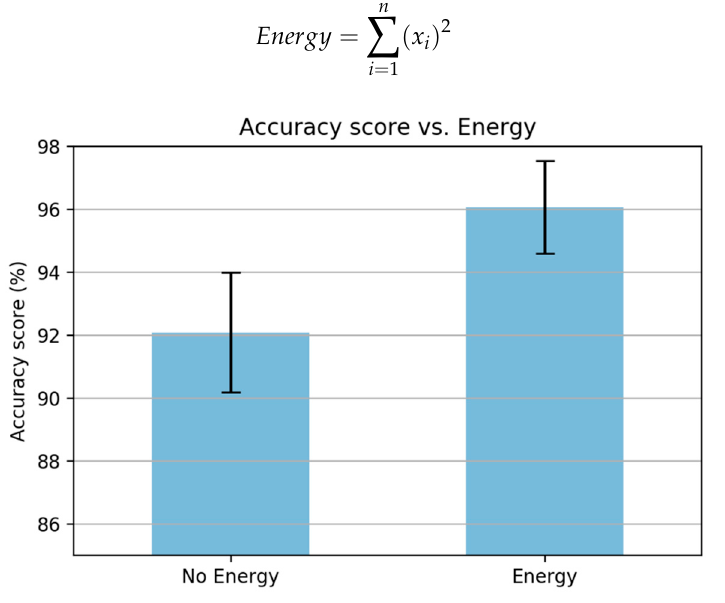
Figure 10. A comparison when removing the energy framed signals.